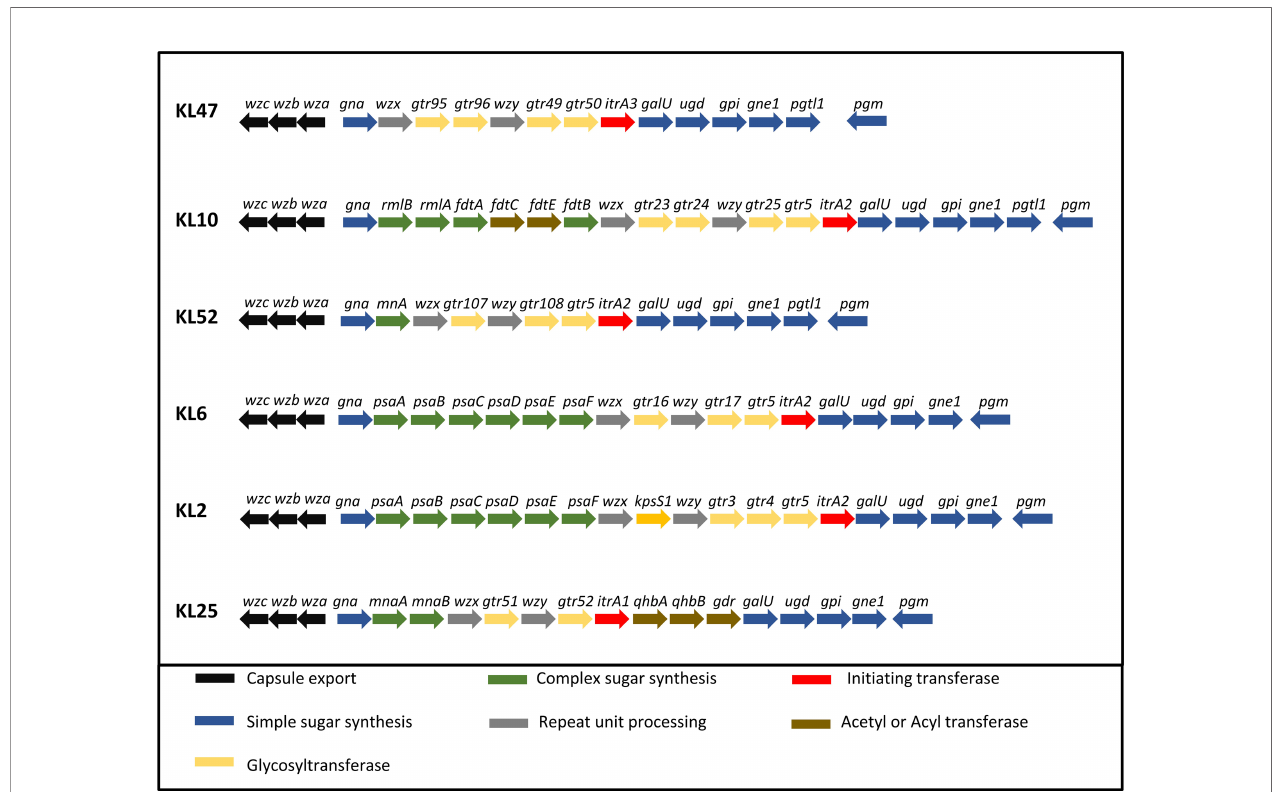
FIGURE 4 | Organization of the fi ve KL loci represented in the A. baumannii strains. A comparison of the CPS biosynthesis genes clusters and their organization in the fi ve KL loci represented in the A. baumannii strains. CPS export genes are in black, genes in dark blue are involved in the synthesis of common sugar substrates, genes in green are involved in the synthesis of complex sugars, genes in yellow encode glycosyltransferases, genes in red encode initiating transferases and genes in brown encode Acyl or acetyl